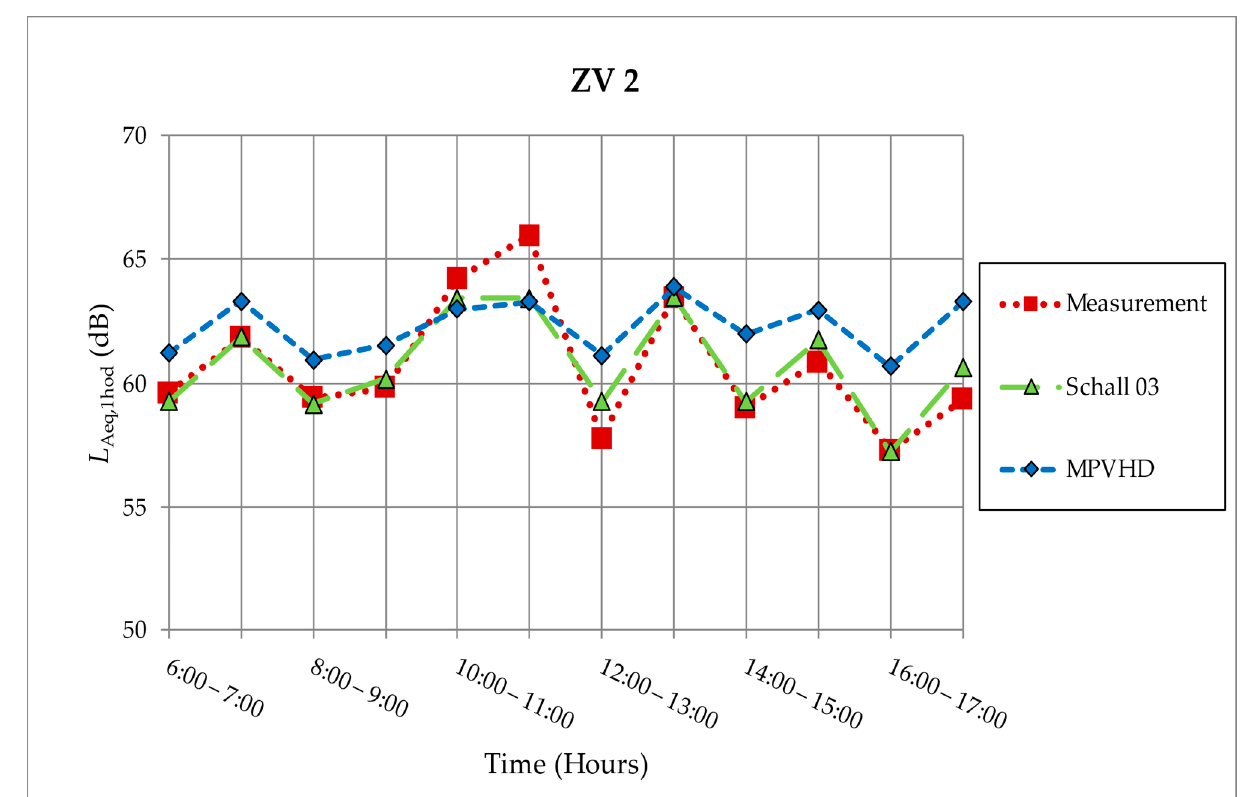
Figure 4. Measurement and prediction of noise from the railway on measurement location ZV2 [10,30,31]. Table 2. Number and type of trains during the measurement